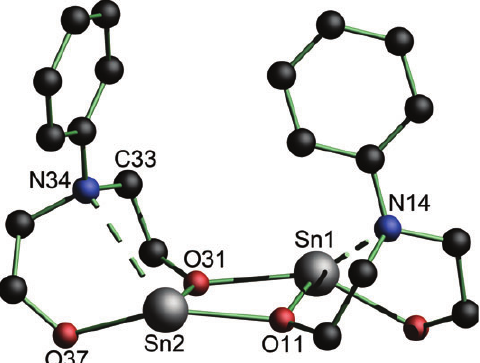
Figure 2 Asymmetric unit of compound 3 (Ball and stick presenta- tion and atom numbering scheme. H atoms are omitted for